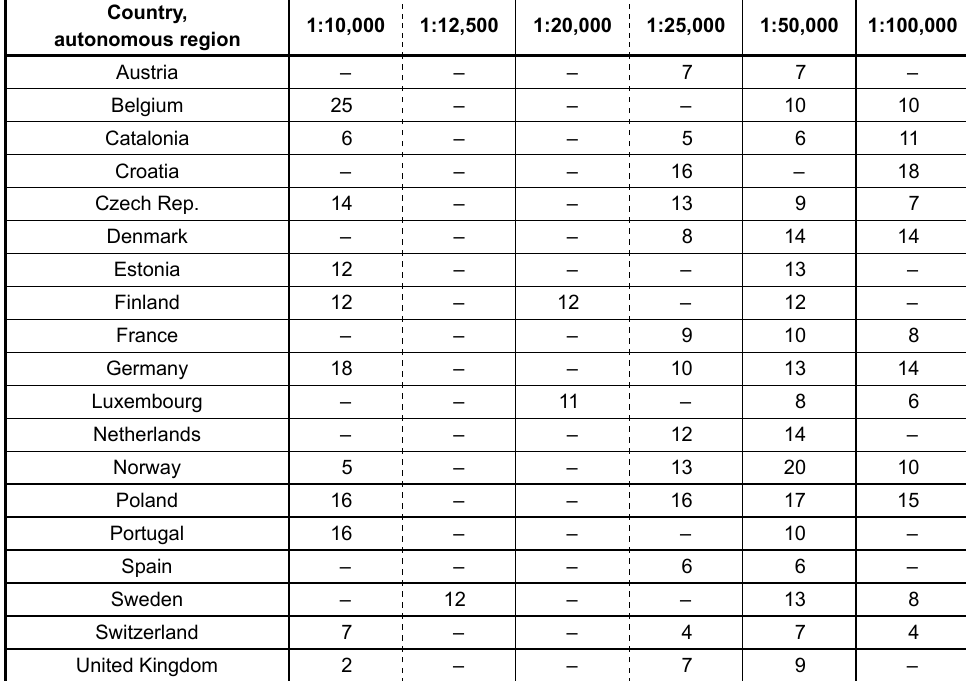
Table 2. Number of content categories concerning build-up areas on the maps included in the analysis Country, autonomous region